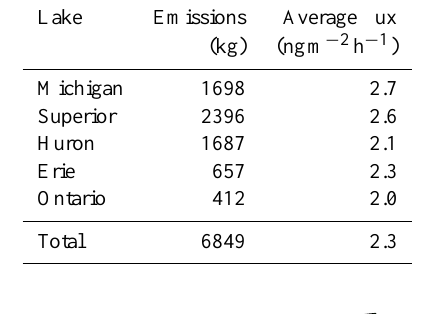
Fig. 2. Gaseous elemental mercury emissions from the lake surfaces summed from 28 June 2004 to 11 May 2005 for WRF domain 1. See Table 1 for total emissions from each lake. Areas with zero emissions shown in white.